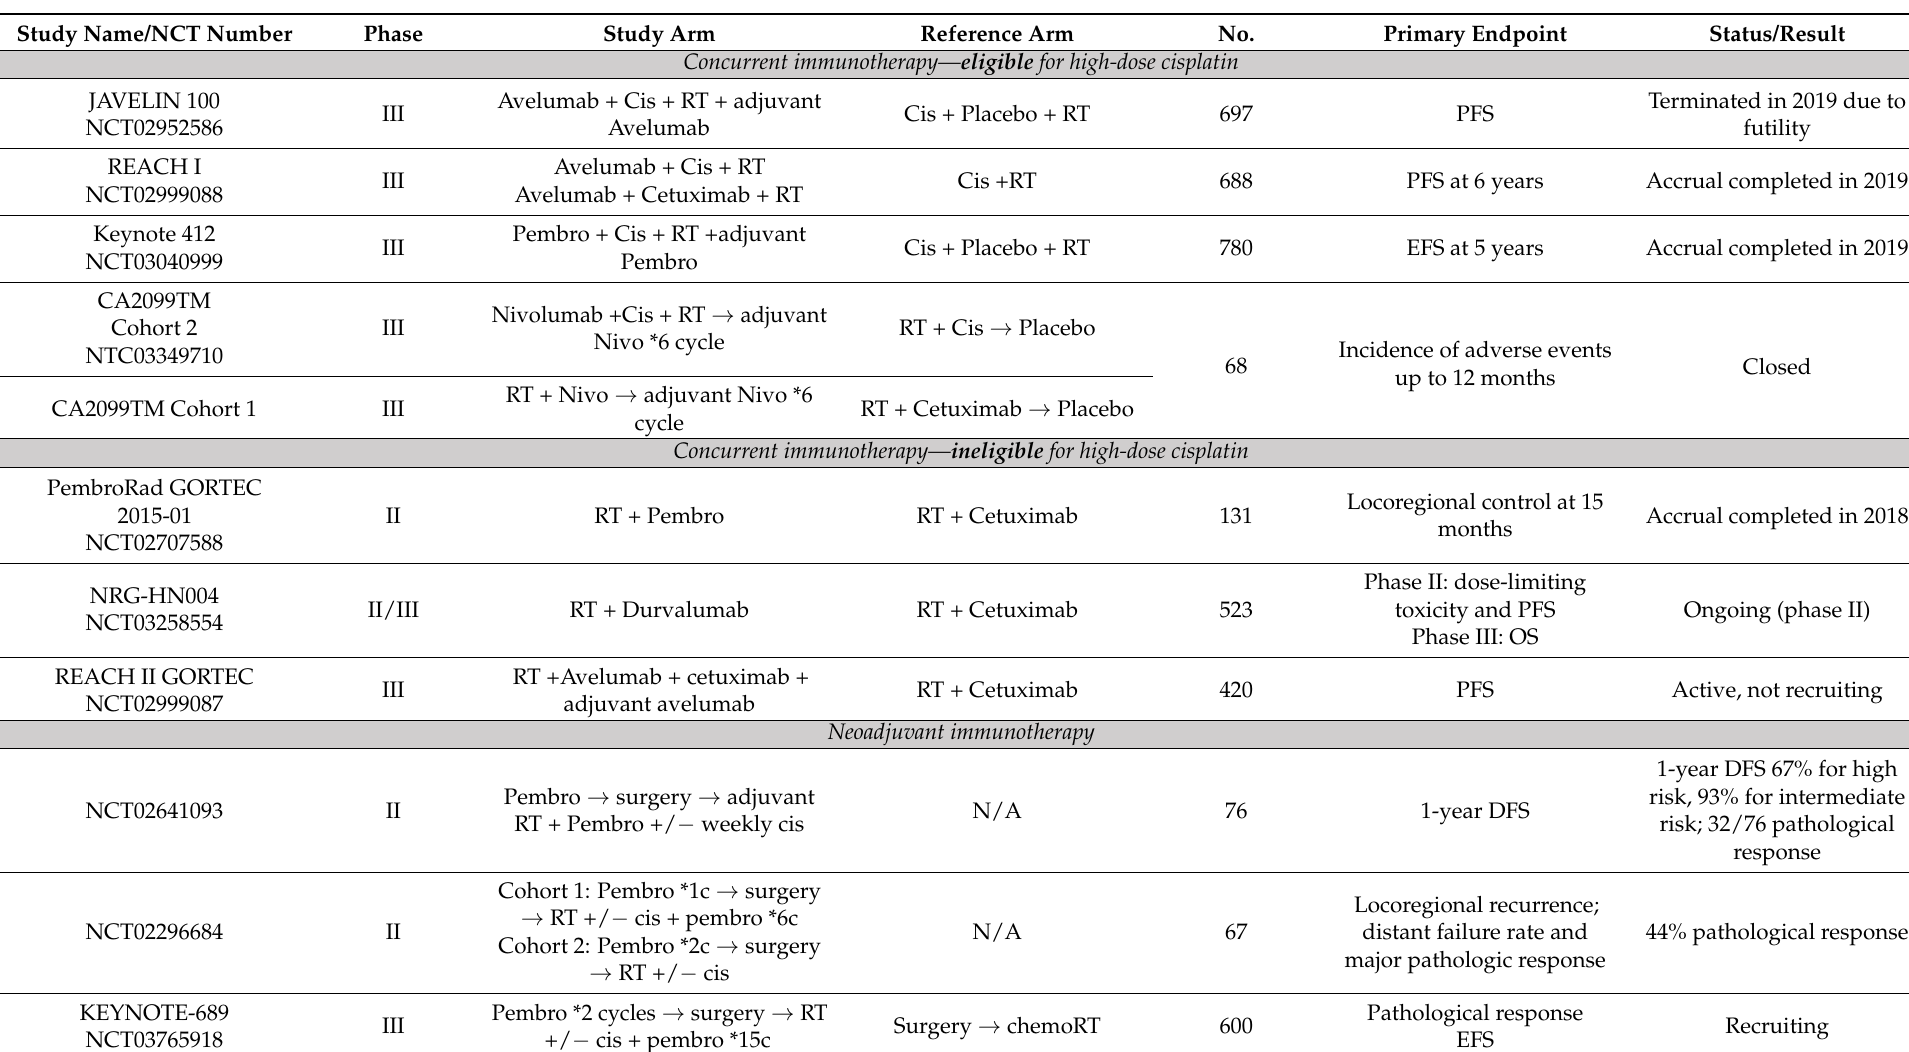
Table 1. Phase II/III trials involving RT with immunotherapy in locally advanced